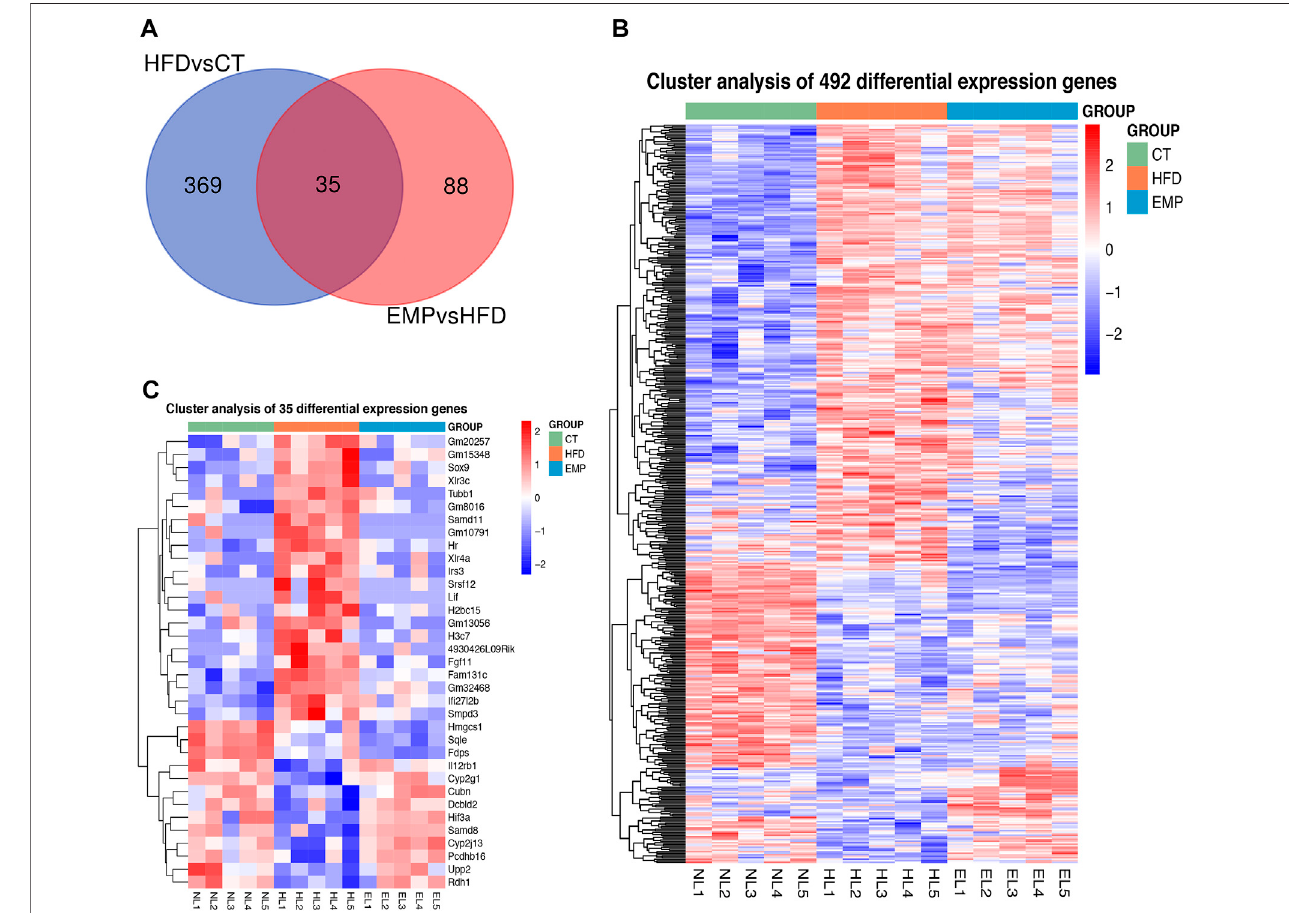
FIGURE3| Theheatmaprepresentingalterationofhepatic union (A) andshared (B) genesexpressionofHFD/CTandEMP/HFD. (C) TheVenndiagramshowsan overlap among the HFD/CT and EMP/HFD genes.